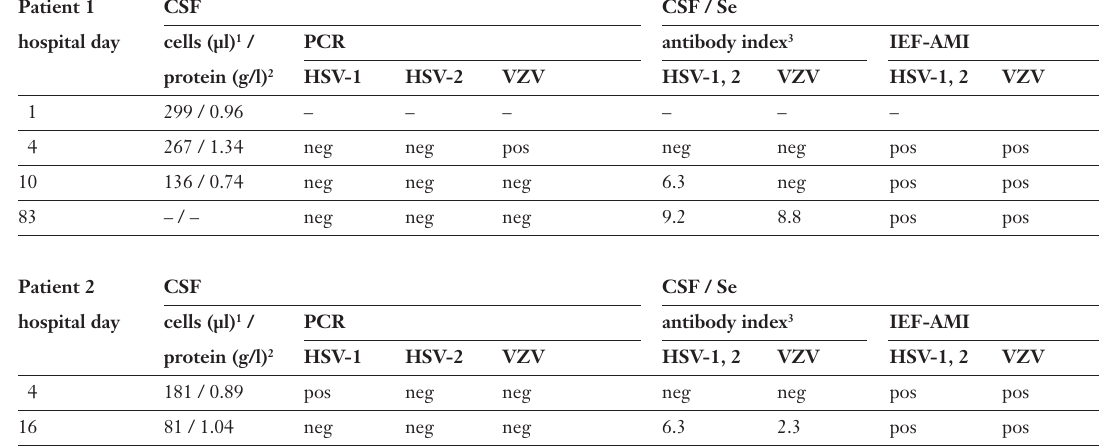
Laboratory results of patient 1 and